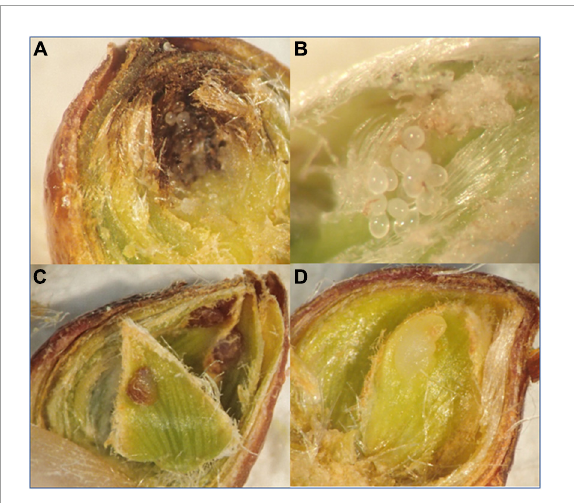
FIGURE3 (A) Eggs surrounded by a necrotic lesion. (B) Dryocosmus kuriphilus eggs inside the bud. (C) Necrotic galls inside the bud. (D) Normal gall developing in leave primordium inside the bud.